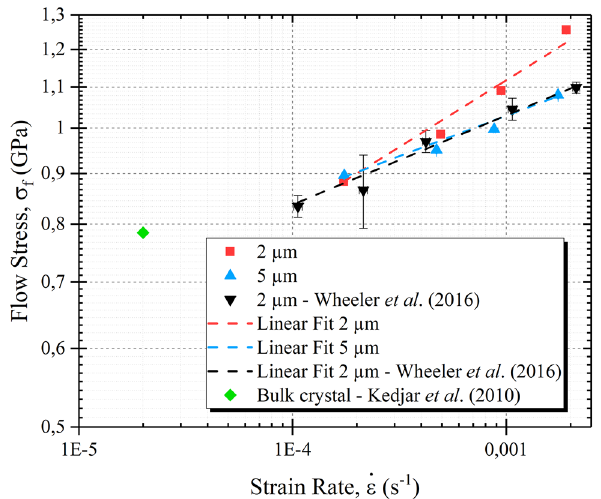
Figure 4. Flow stress with respect to the strain rate for 2 µm, 5 µm micro-pillars and compared to Wheeler et al. results 20 .